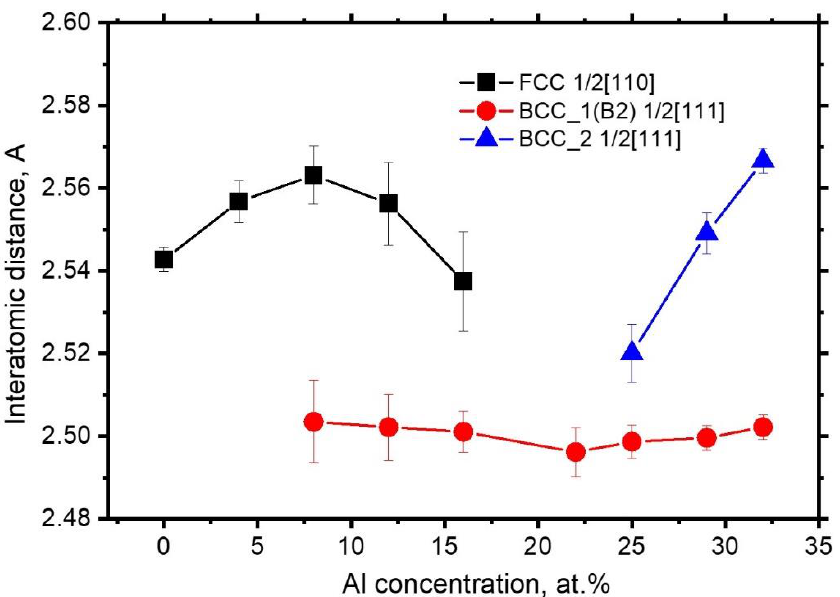
Figure 9. Change in the shortest interatomic distance in the crystal lattice of the solid solutions (FCC or BCC) in dependance of Al concentration in the alloy. The distance was calculated as ½ (110) for FCC and as ½ (111) for BCC lattices.